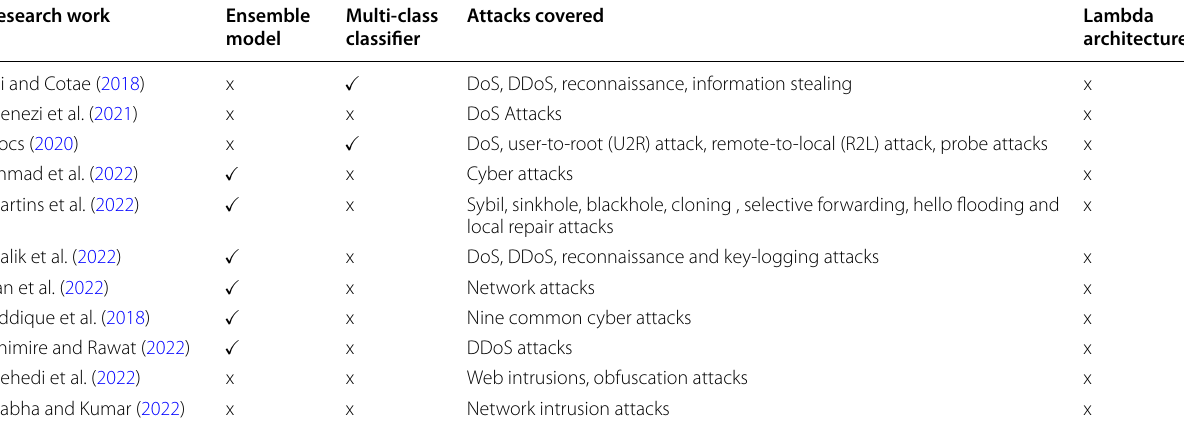
Table 2 Existing IDS approaches for IoT Research